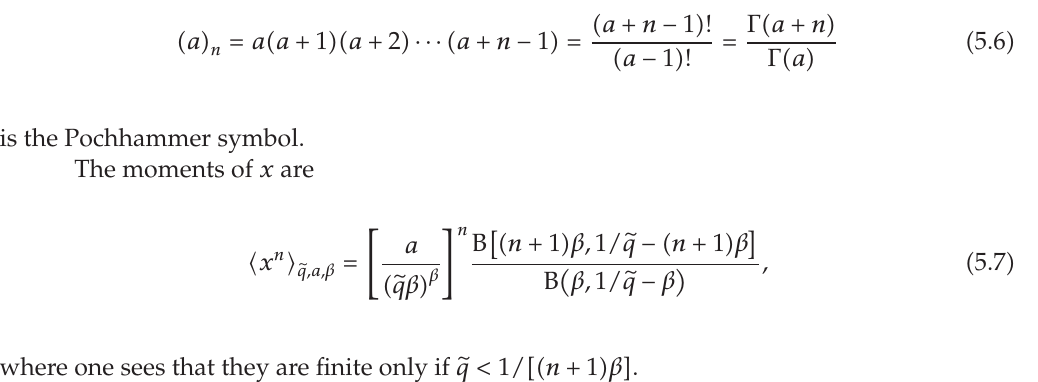
(cid:2) 5.6 (cid:3)